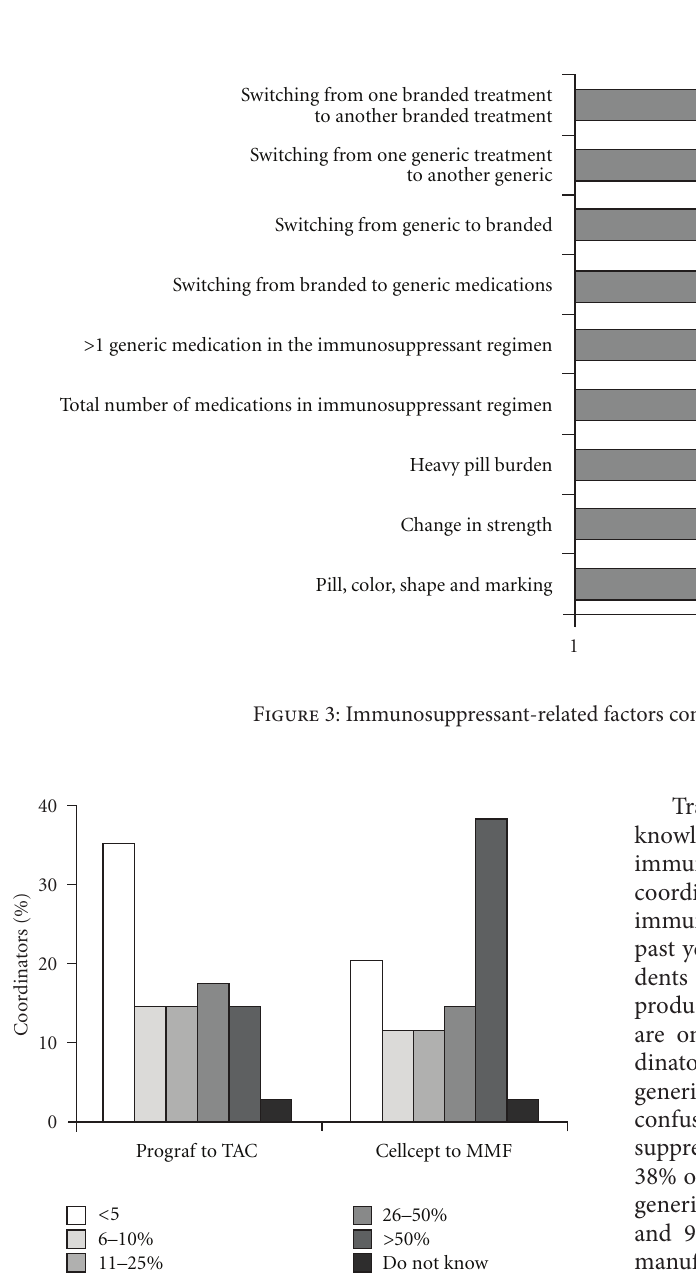
F 4: Proportion of patients switched to generic immuno- suppression therapy. TAC, tacrolimus, MMF, and mycophenolate